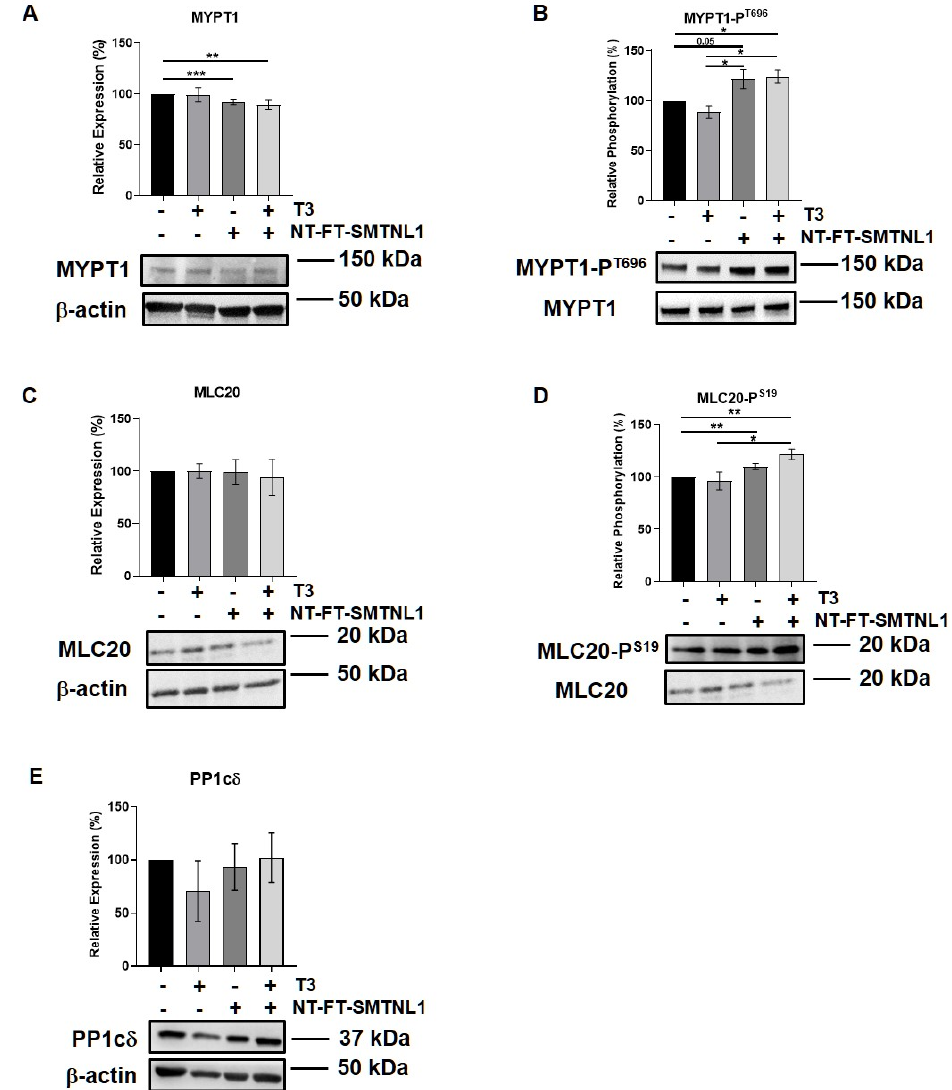
Figure 4. SMTNL1 overexpression controls the phosphorylation of myosin phosphatase and its substrate in myoblasts. Myoblasts were transfected with empty vector or NT-FT-SMTNL1 and were treated with 10 nM T 3 for 24 h. Whole-cell lysates were analyzed using Western blot with anti-MYPT1 ( A ), anti-MYPT1-P T696 ( B ), anti-MLC20 ( C ), anti-MLC20-P S19 ( D ) and anti-PP1c δ ( E ) antibodies. Values represent n = 3, mean ± SEM. Data were normalized to the empty vector-transfected control. Differences between group means were determined using One-way ANOVA and Tukey’s post hoc test, p < 0.05 (*), p < 0.01 (**), p < 0.001 (***).